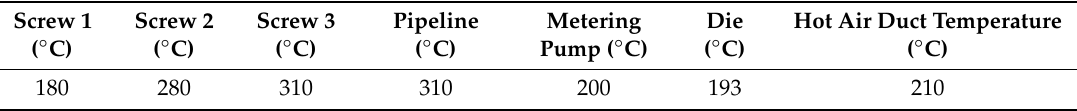
Table 1. Temperatures required for melt blowing.